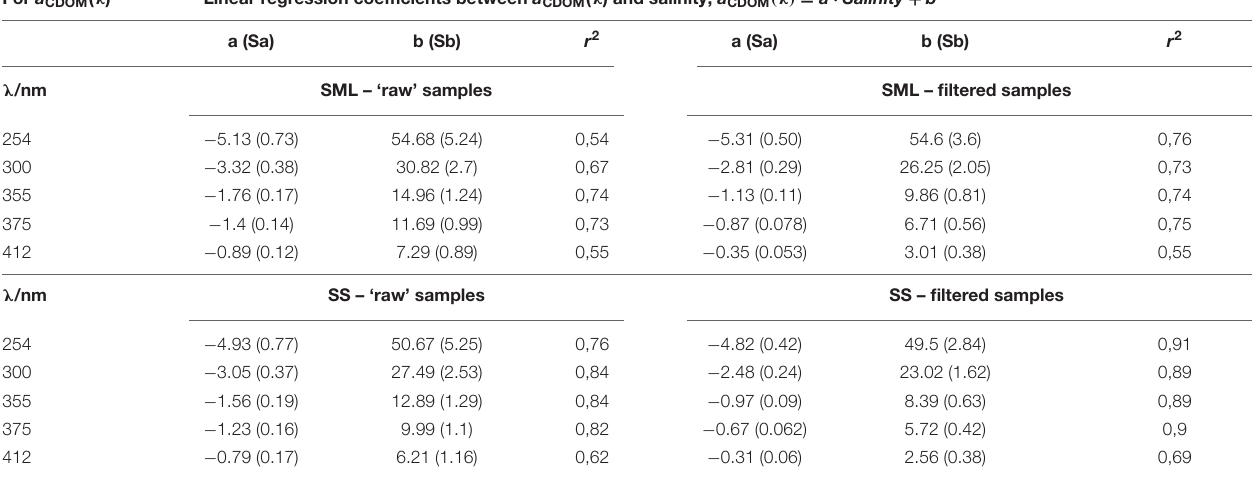
TABLE 1 | The relation between salinity and the CDOM absorption coefficients ( Figure 2 ). For a CDOM ( λ ) Linear regression coefficients between a CDOM ( λ ) and salinity; a CDOM ( λ ) = a · Salinity +